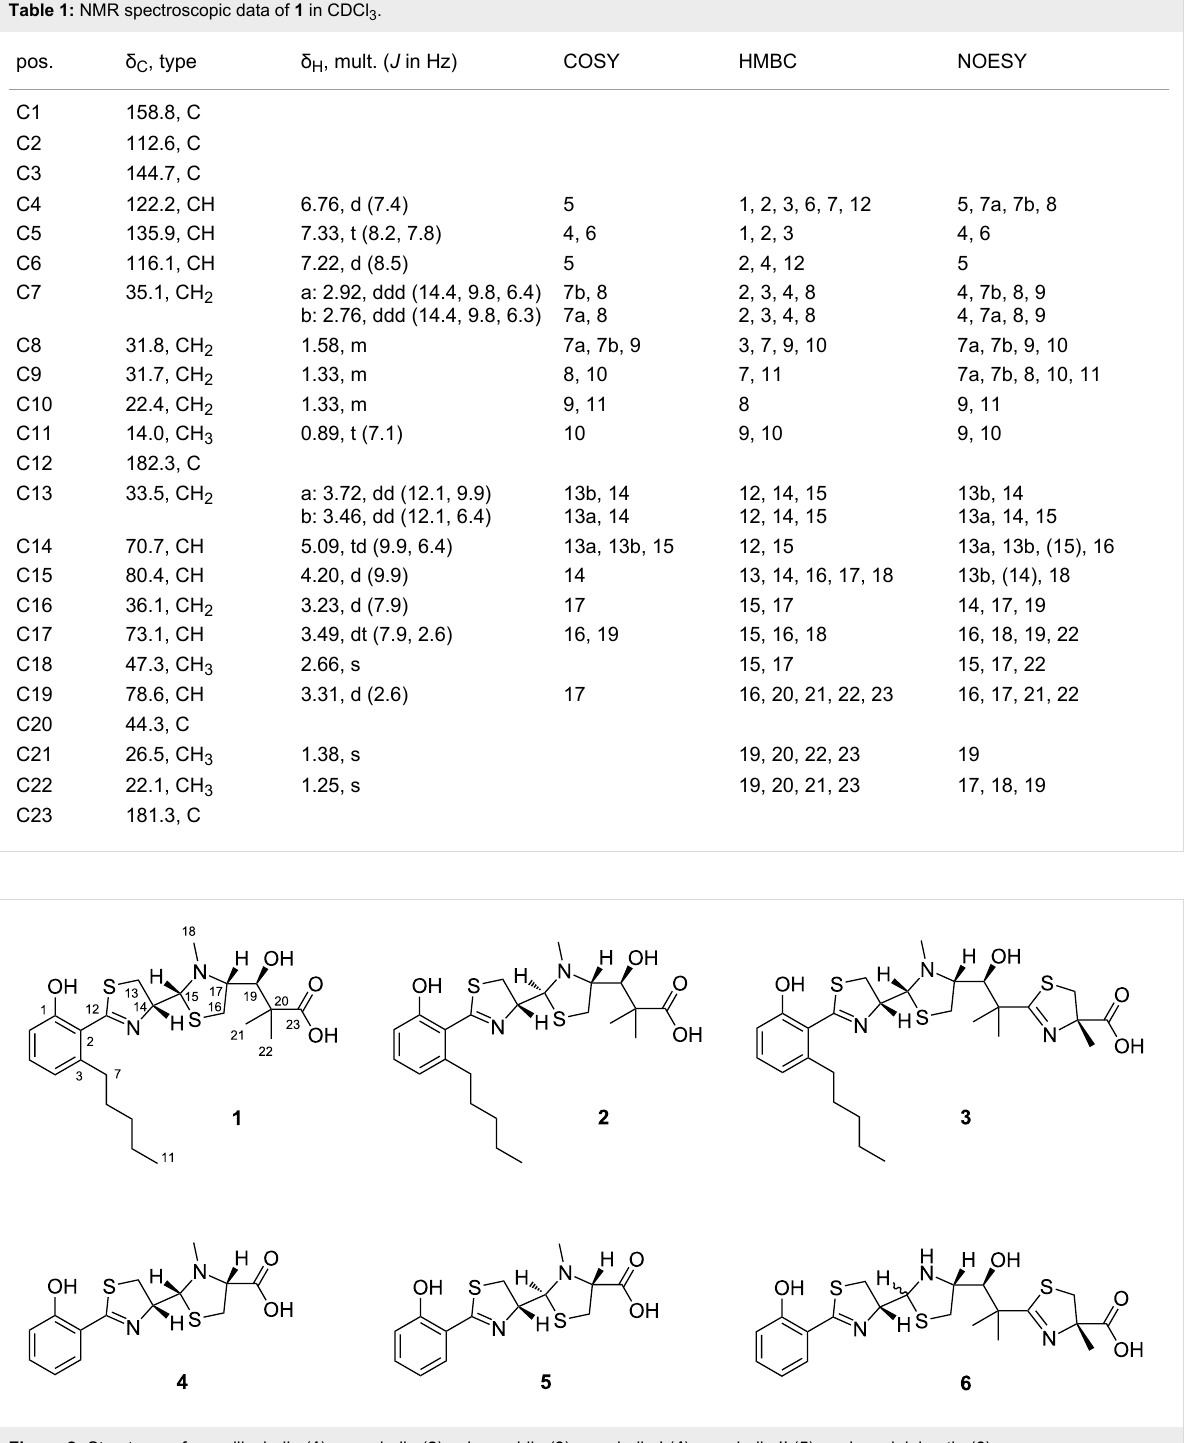
the MicC homolog from Massilia sp. NR 4-1 features only a single adenylation domain for the activation of L-cysteine, which corresponds to the micacocidin and yersiniabactin assembly lines [13,16]. An inspection of the ketoreductase (KR)